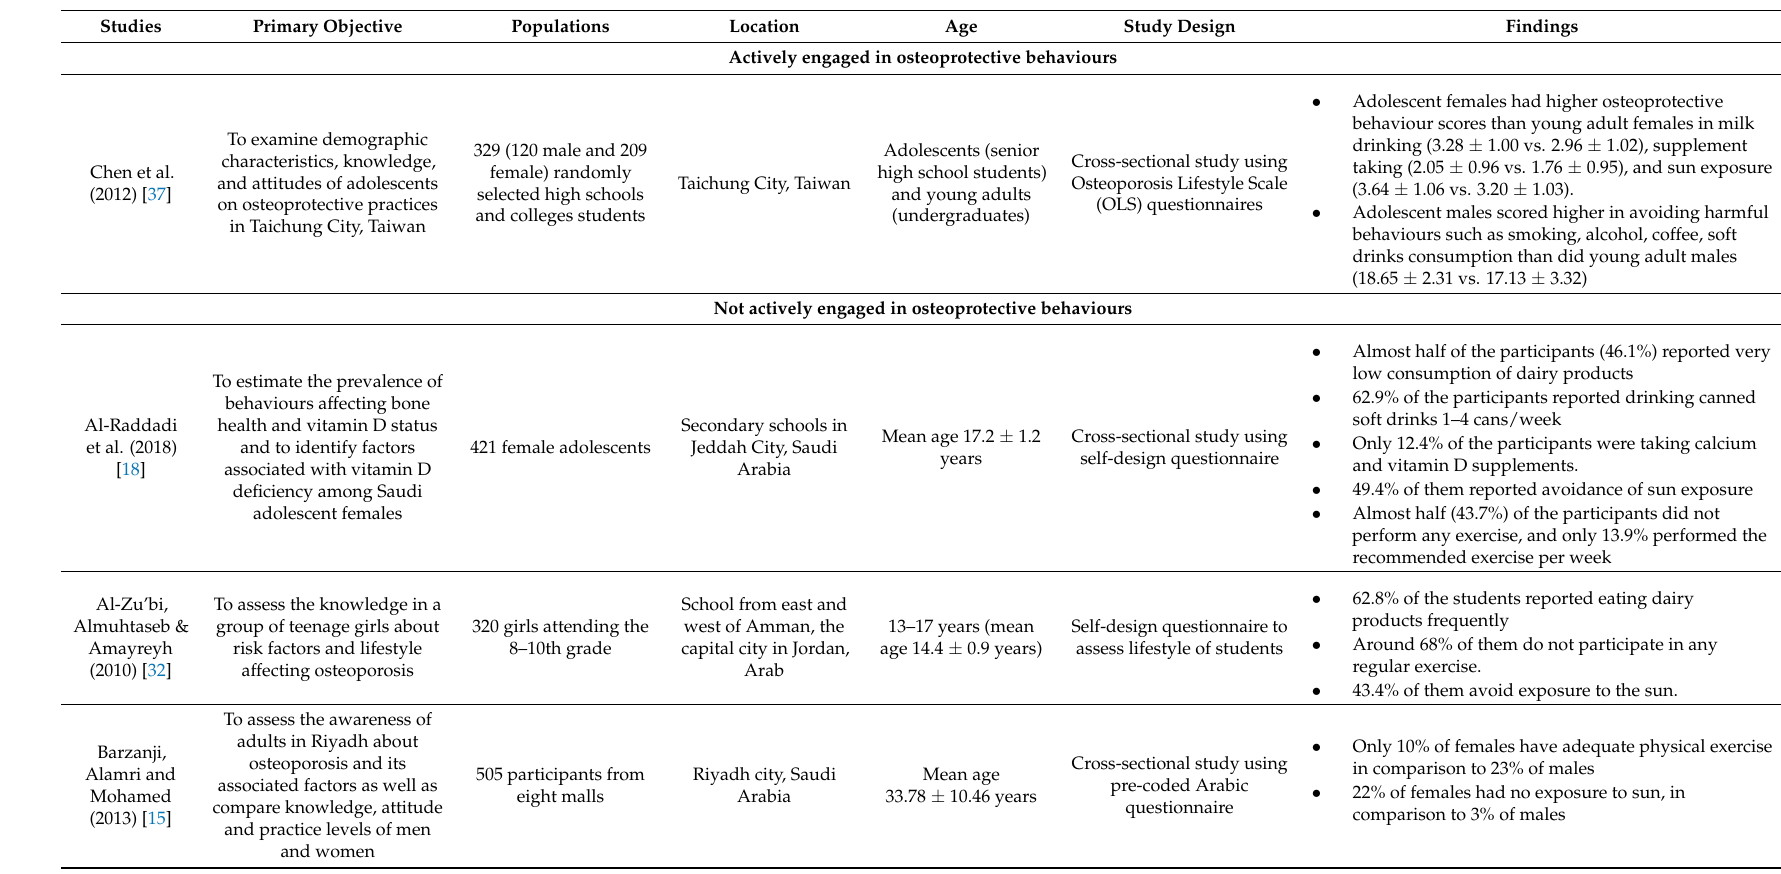
Table 3. Practices affecting bone health among adolescents and young